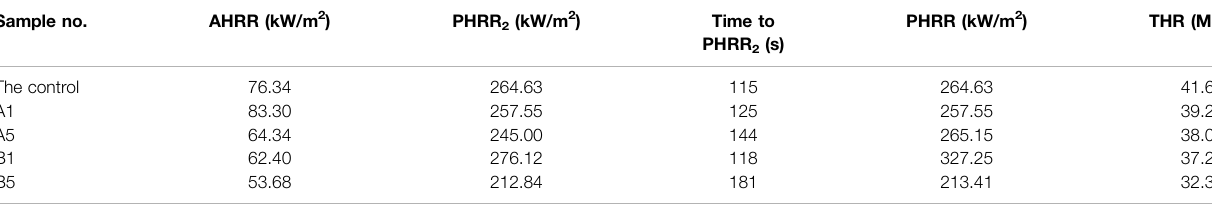
TABLE 3 | AHRR and PHRR of bamboo specimens before and after LbL self-assembly with PA-PEI. Sample no.